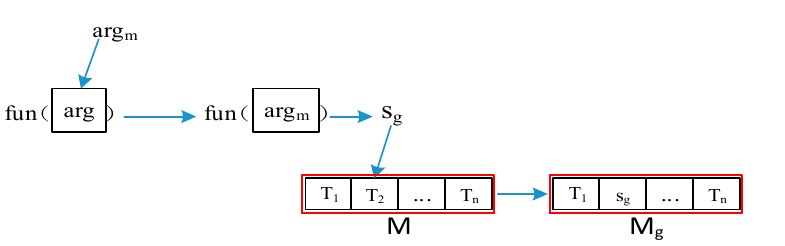
Figure 2. The idea of the Message Construction to Security Protocol Implementation